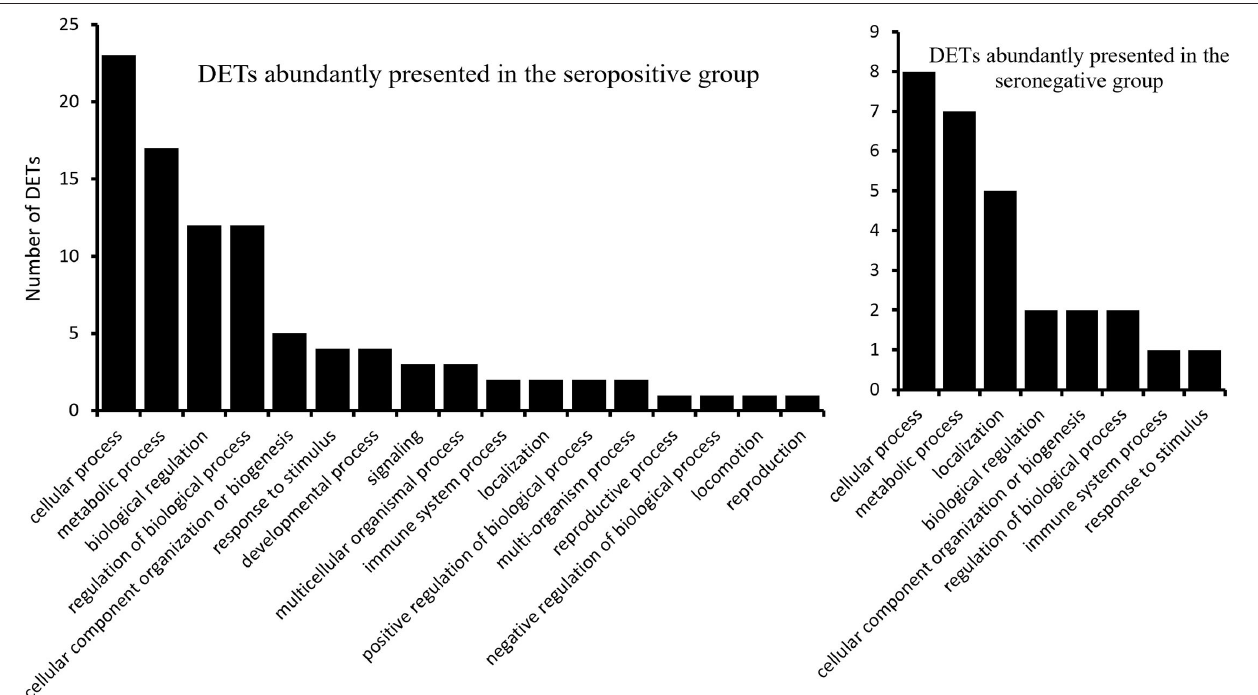
FIGURE 2 | The biological processes (2nd level) of the differentially expressed